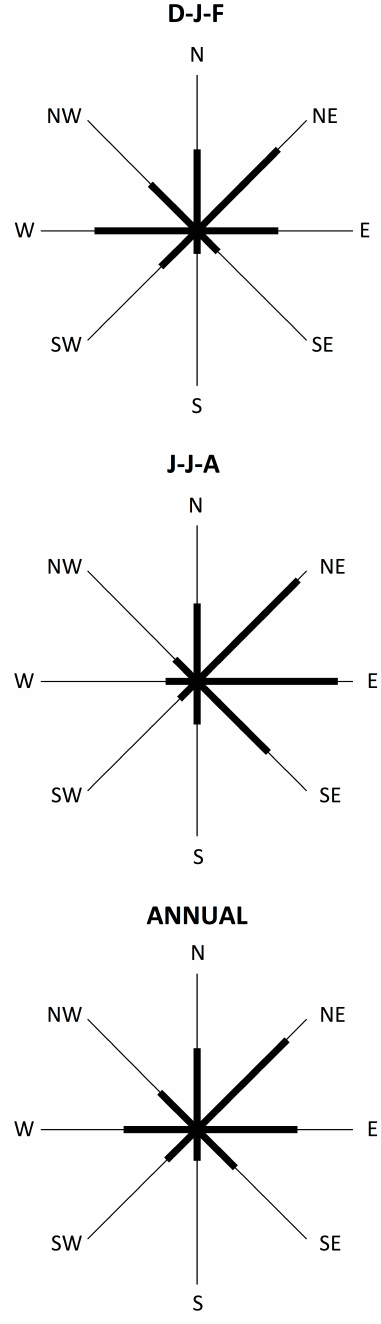
Figure 3. Wind direction at “El Dorado” Observatory in Bogotá, 1977–2001 (IDEAM and Fondo de Prevención y Atención de Emer- gencias, 2007). Top wind rose shows average wind direction for December to February (i.e. the months when the veil and southerly winds were reported by Caldas in Bogotá). Middle wind rose shows average wind direction for June to August, when the Inter Tropical Convergence Zone (ITCZ) is located to the north of Colombia, and lower wind rose is the annual